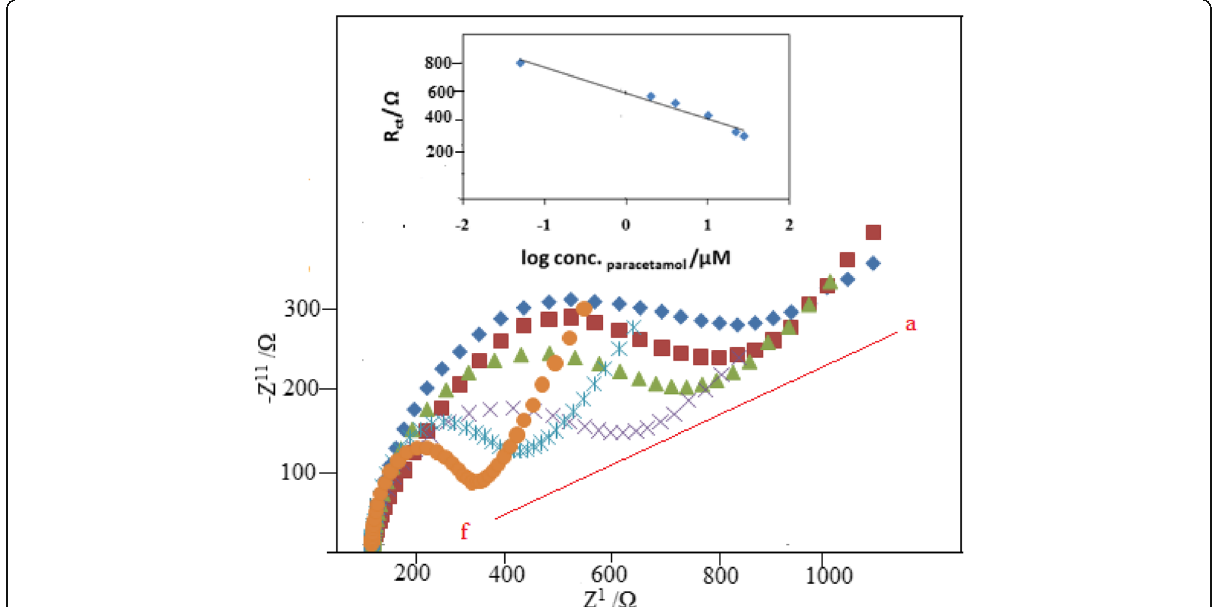
Fig. 11 EIS spectra at B 2 O 3 /MWCNT/GCE for different paracetamol concentrations in 0.1 M PBS (pH 4.0). Inset: variation of R ct with log [paracetamol]/ μ